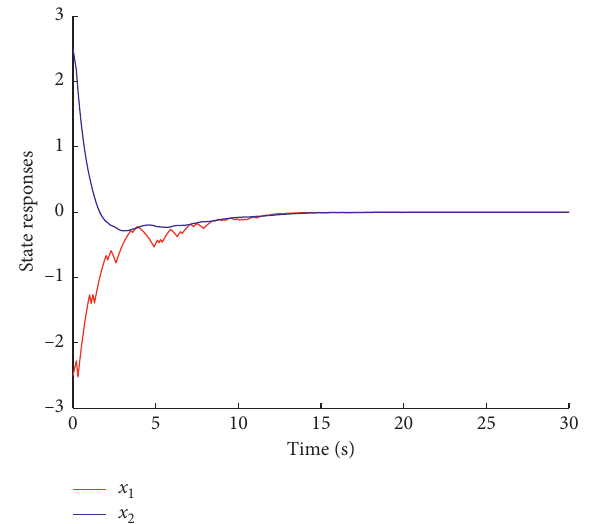
Figure 14: The state response of Example